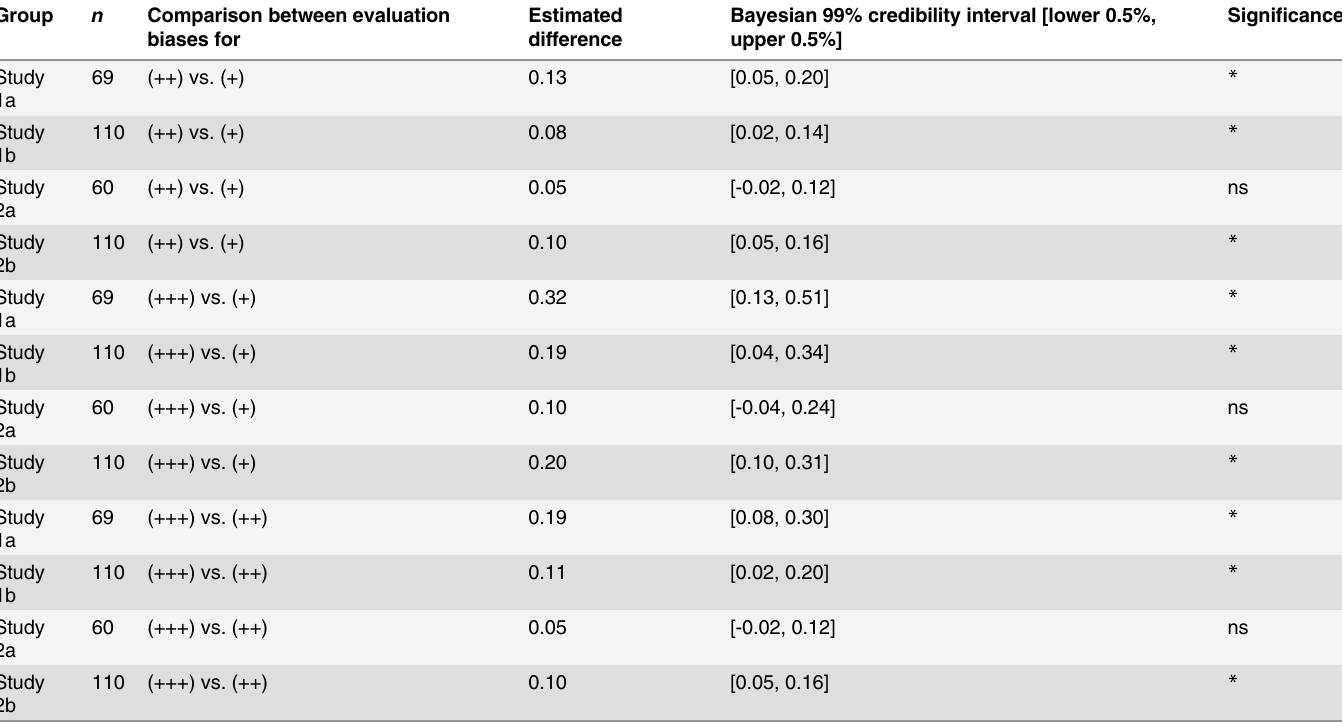
Table 4. Pairwise comparisons between attitudinal evaluation biases within the pro-arguments. Group n Comparison between evaluation biases